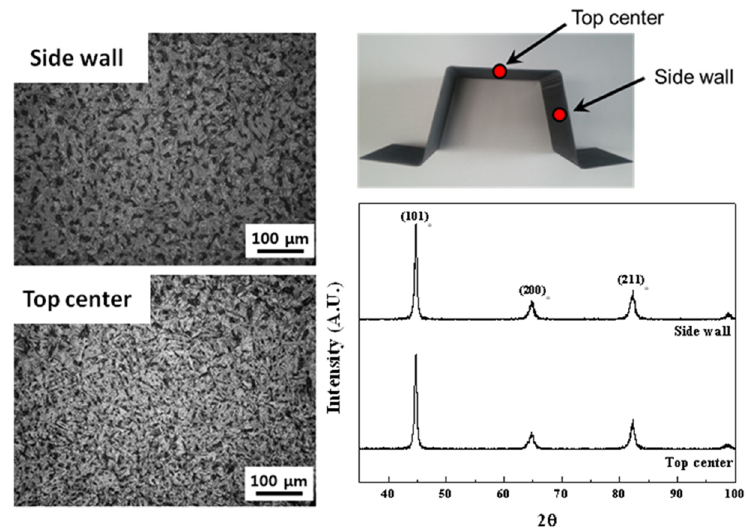
Figure 3. Optical micrograph picture and X-ray diffraction (XRD) data of the